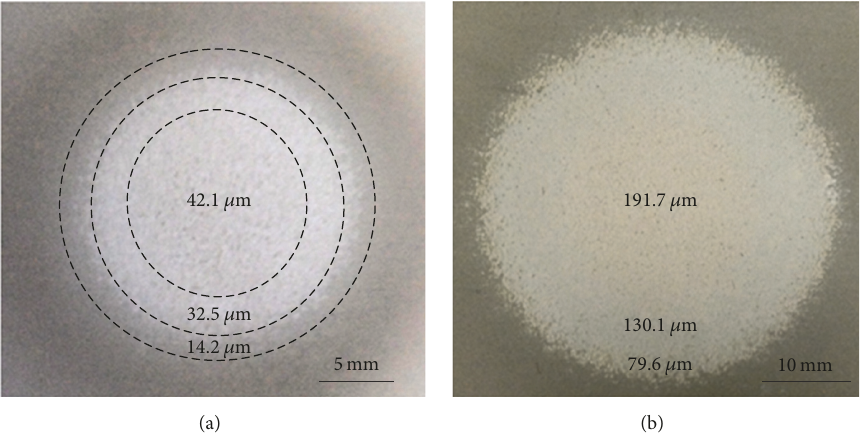
Figure 5: Photographs showing thickness variation in an SMAO coating deposited on an A356 aluminum substrate using AC1 and 5 mm interelectrode gap after (a) 5min and (b) 60min of treatment.